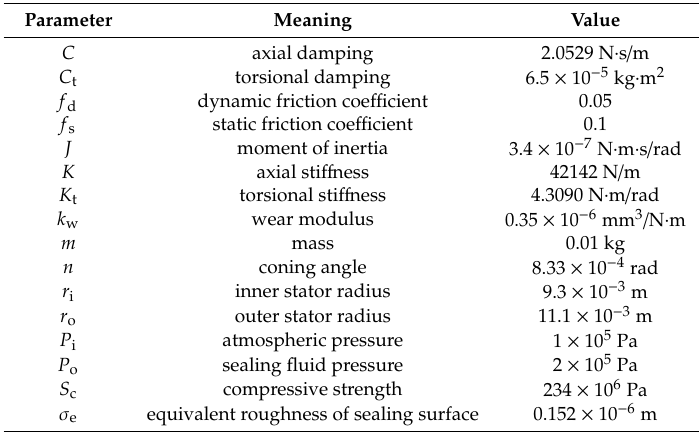
Table 1. The values of the key parameters.